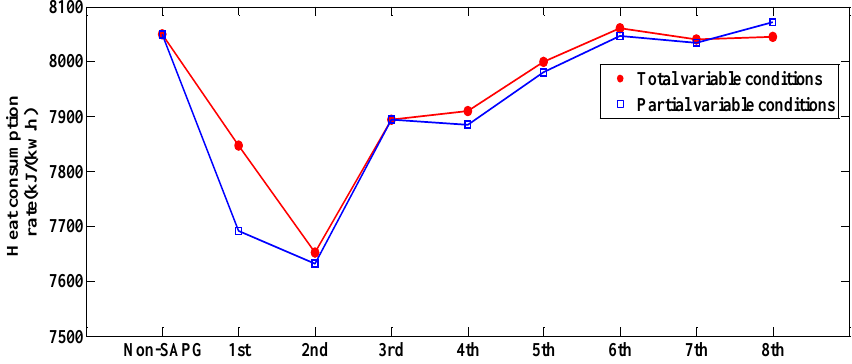
Figure 7. Replace each stage of the heat consumption rate.